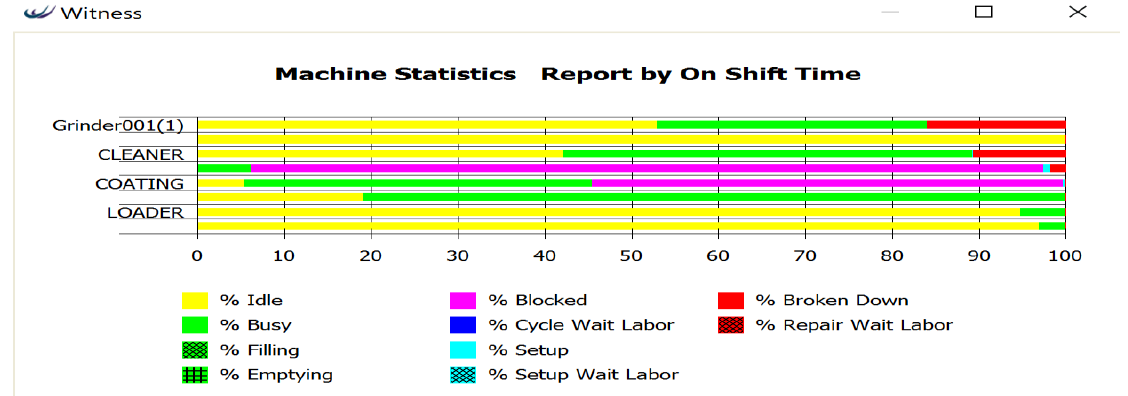
Table 3. Changes based on the budget. Components